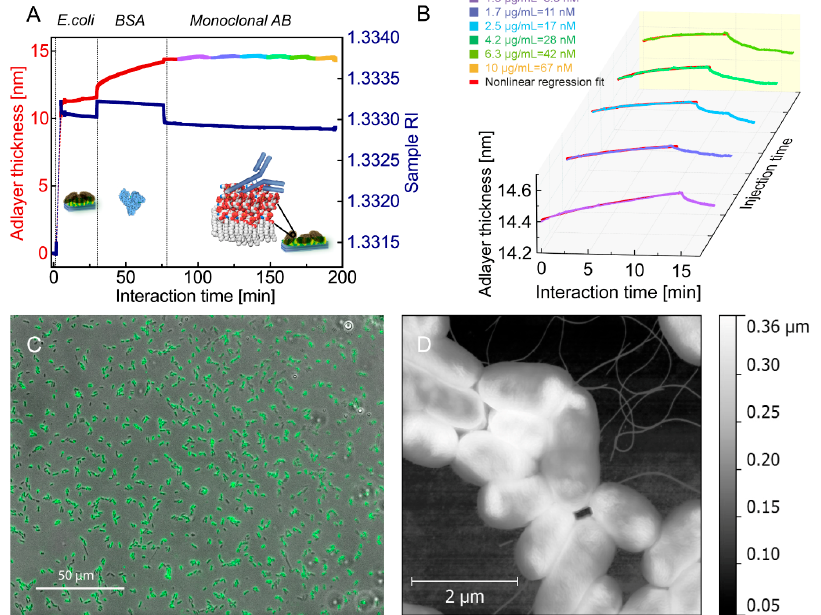
Figure 2. Binding kinetics of monoclonal antibodies against lipopolysaccharide (LPS) to living bacteria E. coli measured by a photonic crystal-based biosensor. ( A ) A typical sensorgram of E. coli attachment (first five minutes), blocking by bovine serum albumin (BSA) (after 30 min), and binding kinetics of antibodies against lipopolysaccharides to living bacteria (after 87 min, colored curves). Here, a simultaneous measurement of the adsorbed layer thickness (left red axis) and bulk refractive index (right blue axis) takes place, see also Figure 1 for the biosensor setup. The inset cartoons depict BSA and antibody on the bacterial membrane; ( B ) antibody binding measured at different concentrations: association and dissociation phases, 15–20 min between injections of antibody solutions. The association phases are fitted by a nonlinear regression algorithm (see explanation in the text), the fitting curve is displayed red; ( C ) immunofluorescence imaging of unlabeled primary mouse monoclonal antibodies (targeting LPS of E. coli during the experiment in vitro) recognized by anti-mouse secondary antibodies Alexa 488 dye-conjugated (attached onto the chip after the experiment), obtained by wide-field epifluorescence microscopy; ( D ) a topography atomic force microscopy (AFM) image of E. coli with flagella attached to the photonic crystal chip (performed in air after the binding experiment).